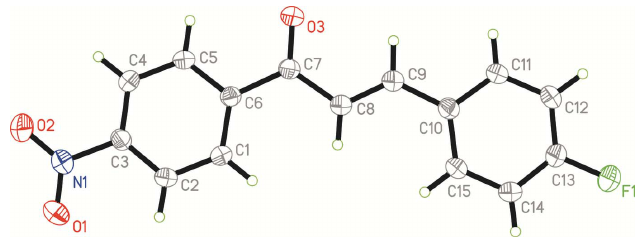
Figure 1 The molecular structure of the title compound with atom labels and 30% probability displacement